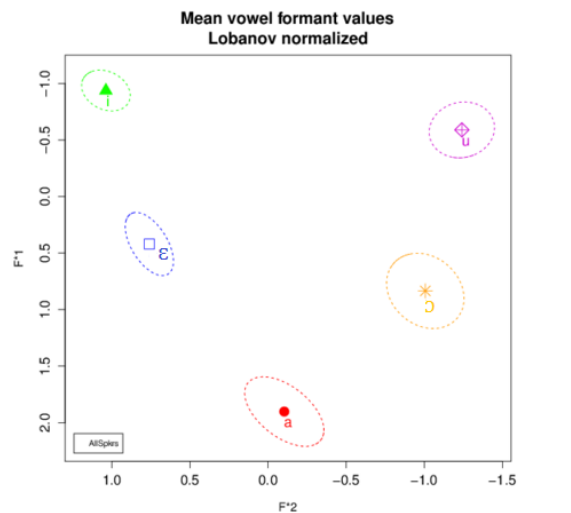
Figure 3: Average Lobanov normalized F1–F2 values for 5 male Deori